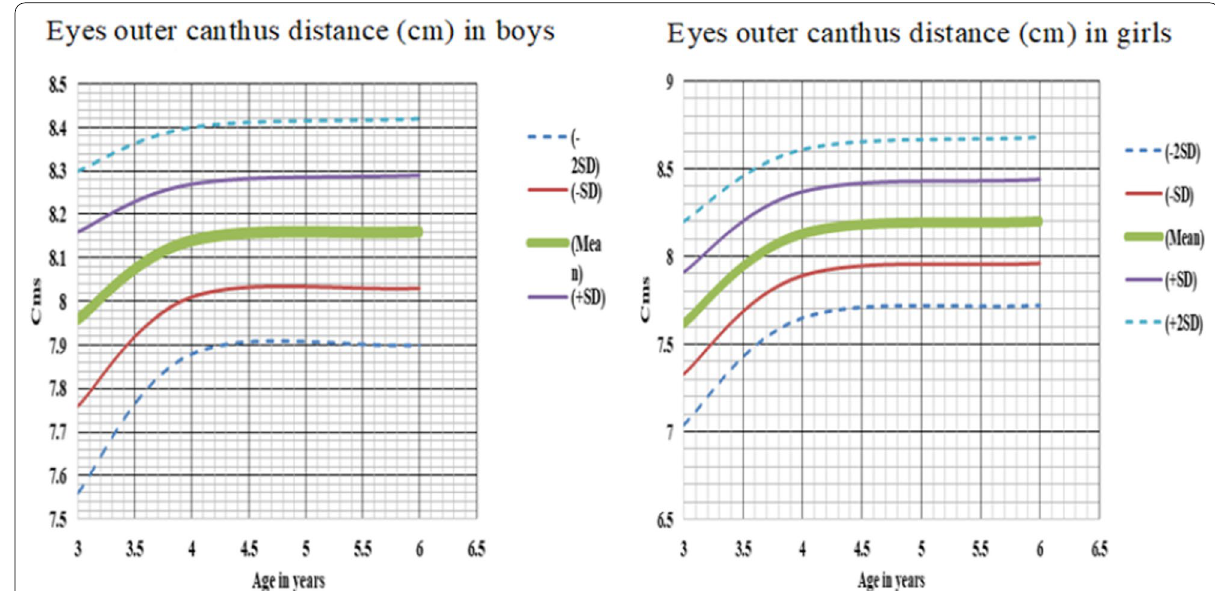
Fig. 3 Eyes outer canthus distance (cm) in boys and